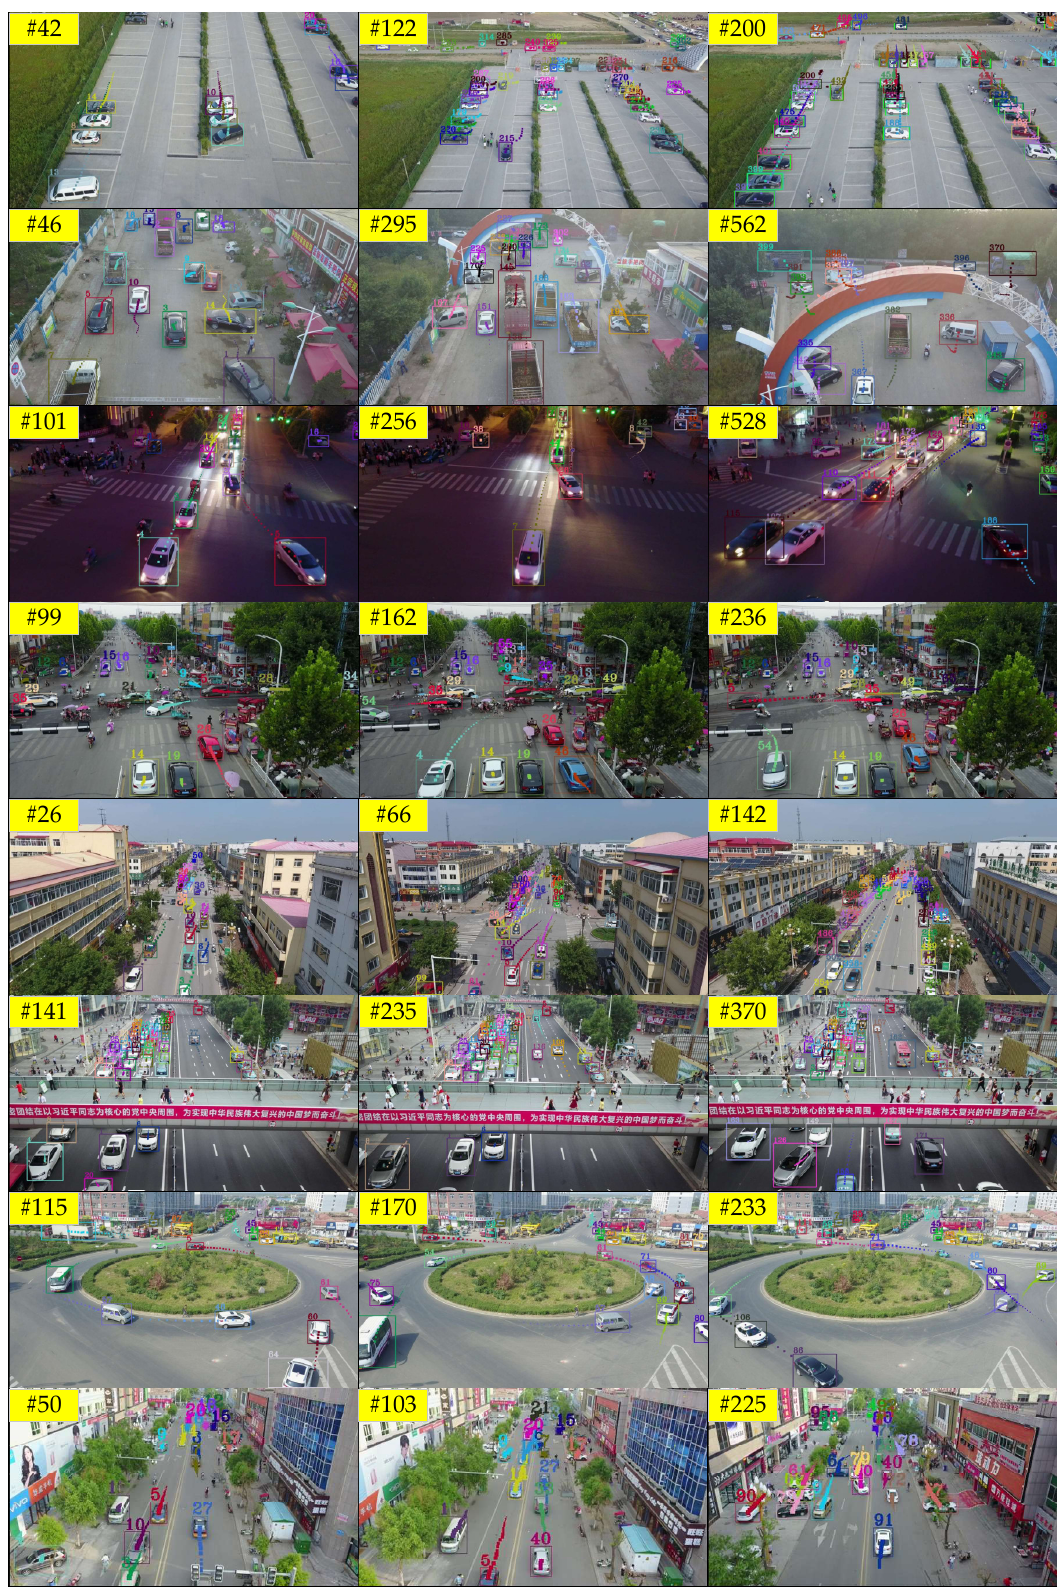
Figure 12. Tracking results of the FPUAV on